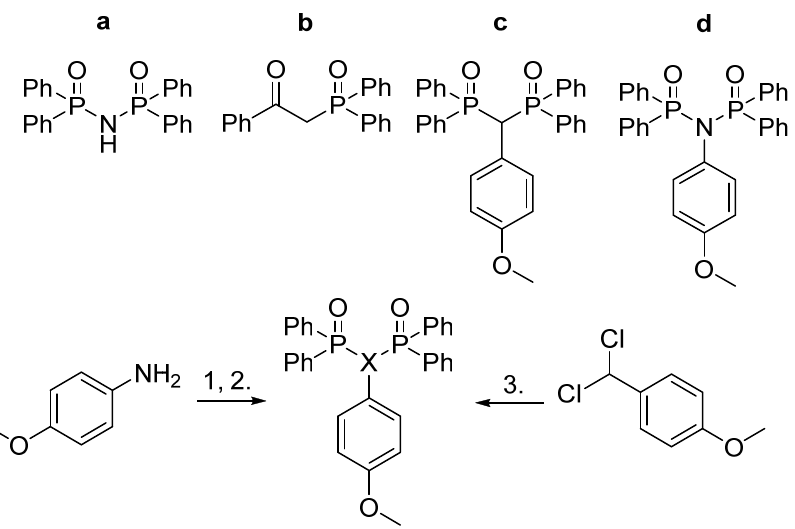
Figure 1. Ligands synthesized for this study: N -(diphenylphosphoryl)- P , P -diphenylphosphinicamide ( a ), 2-(diphenylphosphoryl)-1-phenylethan-1-one ( b ), ((4-methoxyphenyl)methylene)bis(diphenylphosphine oxide) ( c ), N -(diphenylphosphoryl)- N -(4-methoxyphenyl)- P , P -diphenylphosphinic amide ( d ). Synthetic routes employed in this work to synthesize new ligands c and d with p -methoxyphenyl substituent at α - position.